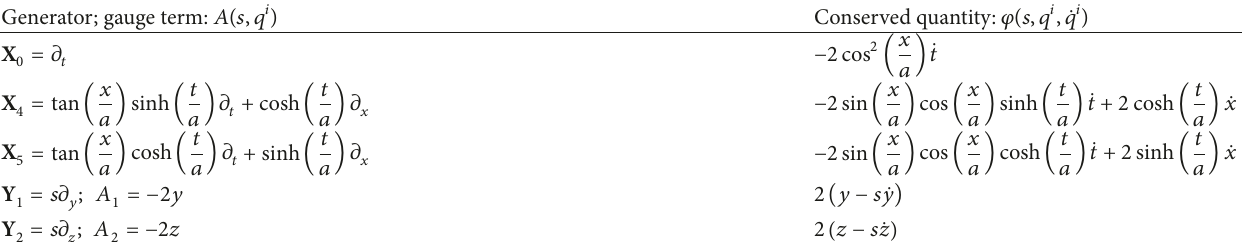
Table 8: Conserved quantities corresponding to each Noether symmetry.